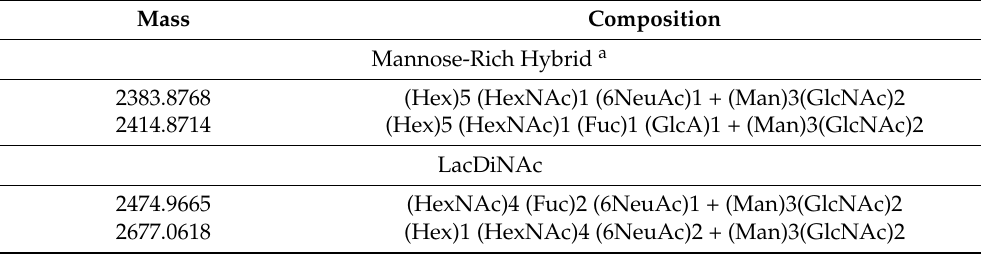
Table 5. Estimating glycan composition with R 2 > 0.8 of mannose-rich hybrid and LacDiNAc moieties. Mass Composition Mass